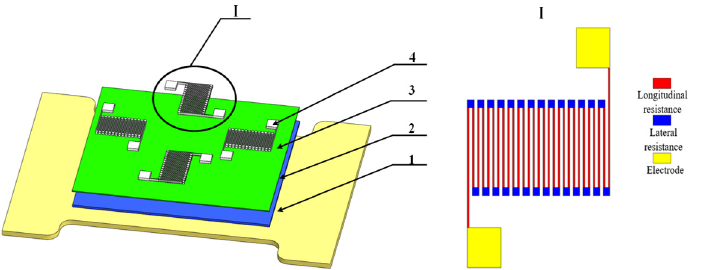
Figure 2. Structure of thin-film strain sensor and resistance grid. 1, Elastic substrate; 2, Transition layer; 3, Insulating layer; 4, Resistance grid layer.